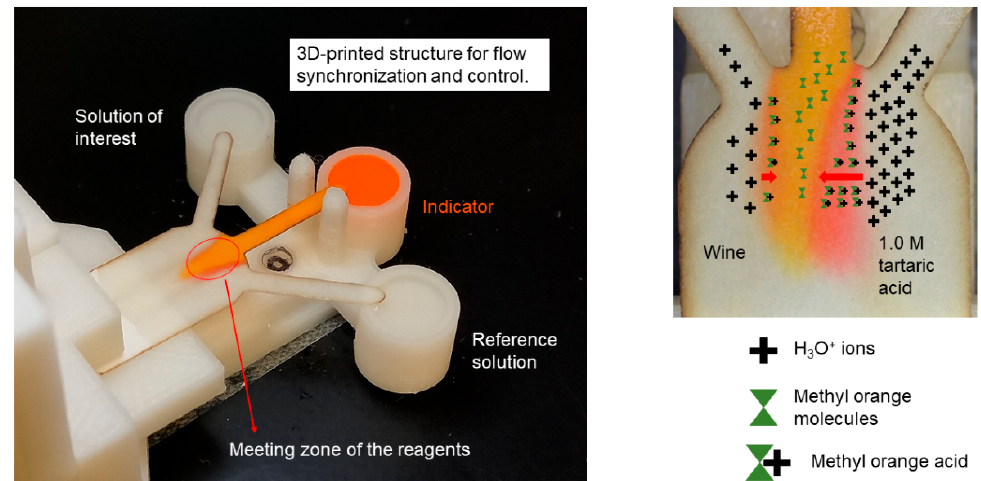
Figure 1. Picture of the ionic strength wine evaluation using a diffusion-based µPAD and the flow control system. Red arrows illustrate the diffusion widths due to unequal ionic concentration of solutions in the meeting zone.